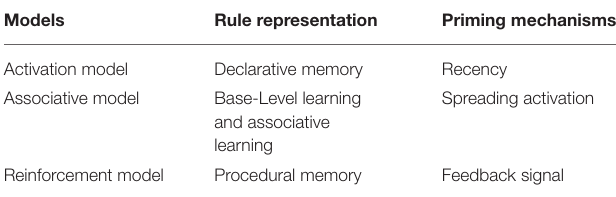
TABLE 1 | Overview of the differences between